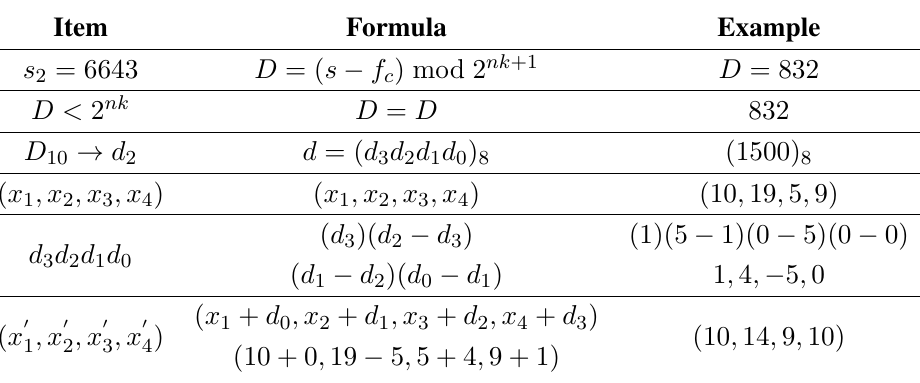
Table 2. Speeding up the embedding method when D < 2 nk